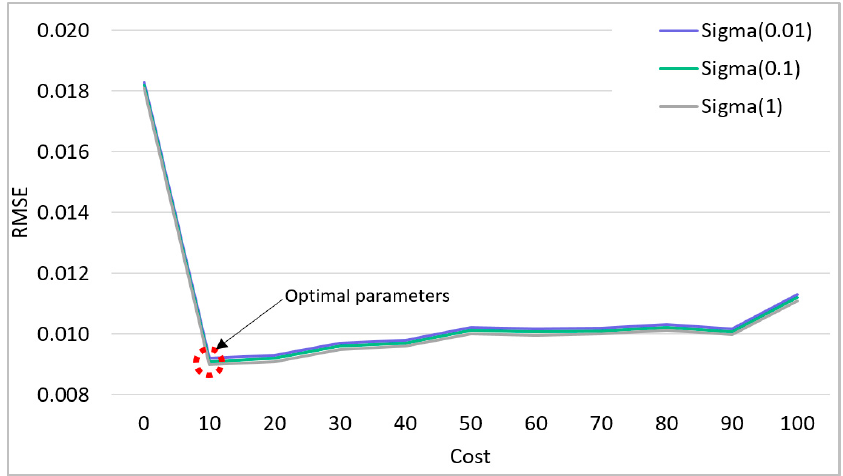
Figure 5. Selection of optimal parameters of Support Vector Regression.